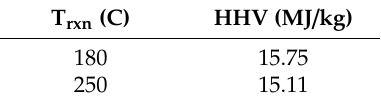
Table 6. Higher Heating Value [MJ / kg] obtained by using the ultimate composition by Reference [34].